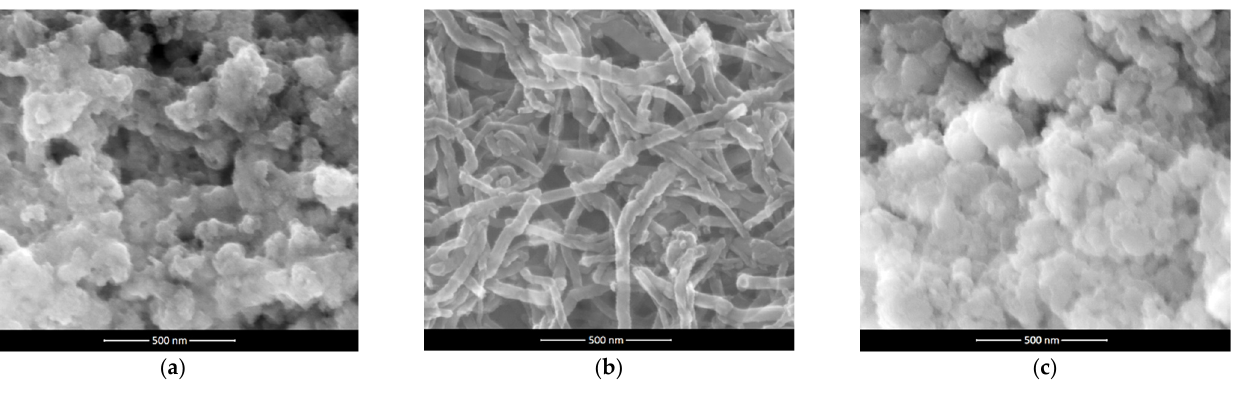
Figure 1. SEM scans of ( a ) hydrous cerium dioxide, ( b ) hydrous cerium dioxide—carbon nanotubes, ( c ) hydrous cerium dioxide—poly(3-octylthiophene-2,5-diyl). SEM experimental parameters—magnitude: 200,000×, detector: Helix, voltage: 18.0 kV, horizontal field width: 1.42 μ m.